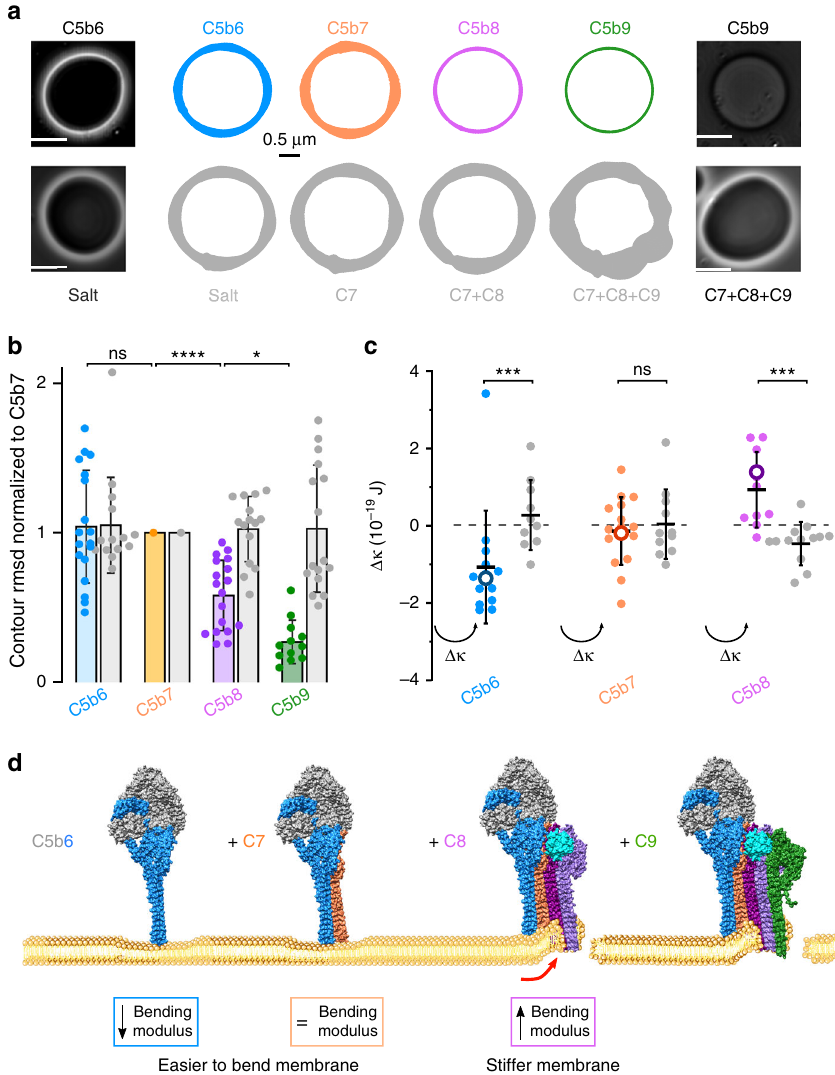
Fig. 4 Flicker spectroscopy informs a biophysical timeline of pore formation. a Phase contrast light microscopy was used to visualize membrane fl uctuations of GUVs after addition of complement proteins (top row) or when buffer replaced C5b6 (bottom row). Formation of functional pores allowed passage of sucrose across the bilayer, resulting in loss of contrast (left and right panels). White scale bar, 10 µ m. Colored contours depict the mean root- mean-square deviation (RMSD) value of membrane fl uctuations for a representative GUV after the addition of complement proteins. Black scale bar for RMSD, 0.5 µ m. b Individual dots show the RMSD of membrane fl uctuations for each GUV normalized the fl uctuations after C7 addition. Bar graph represents the mean and is colored according to contour plots in a . Error bars represent standard deviations. P values comparing the membrane fl uctuations of individual GUVs through all steps of MAC formation were calculated using a Wilcoxon match-pairs test (**** P < 0.0001, * P < 0.1). c Sequential changes in bending modulus ( Δ κ ) after the addition of C5b6, C7, and C8. Δ κ for individual GUVs tracked during MAC formation are